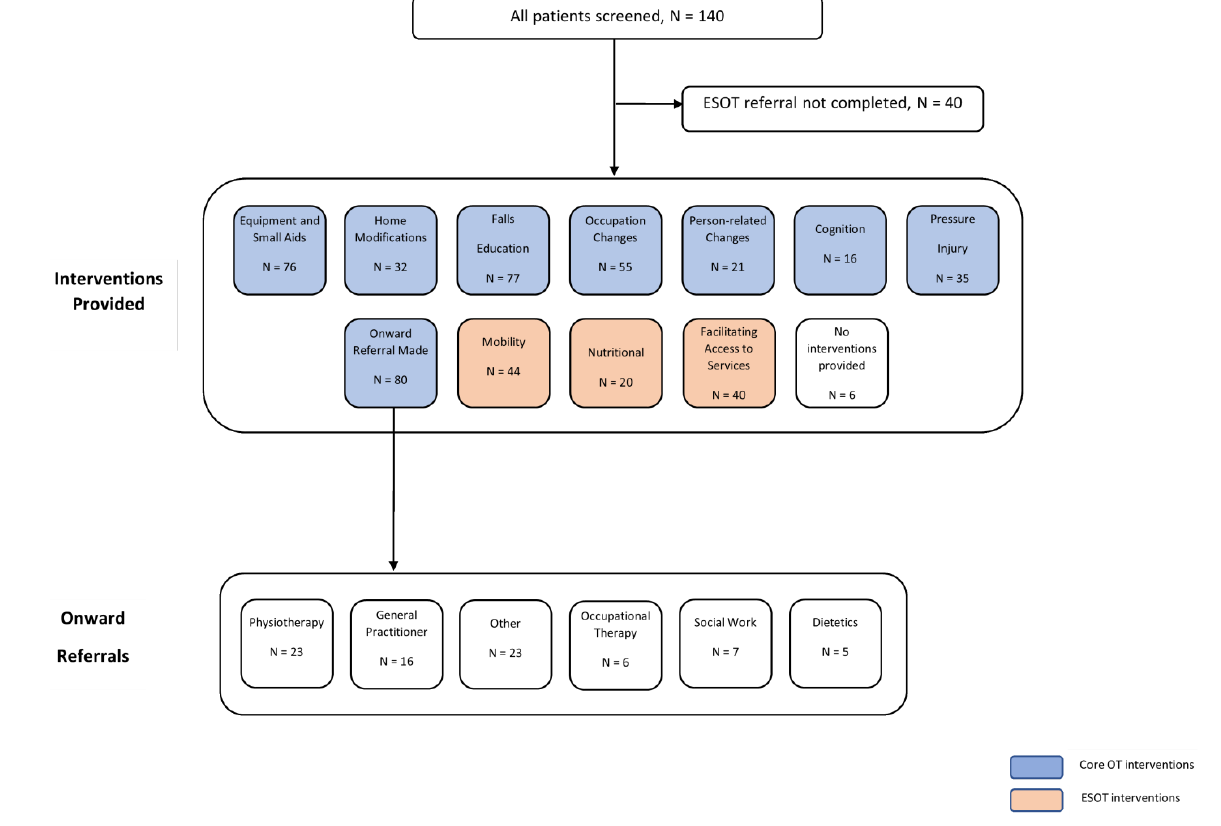
Figure 1. Flow of participants through study.